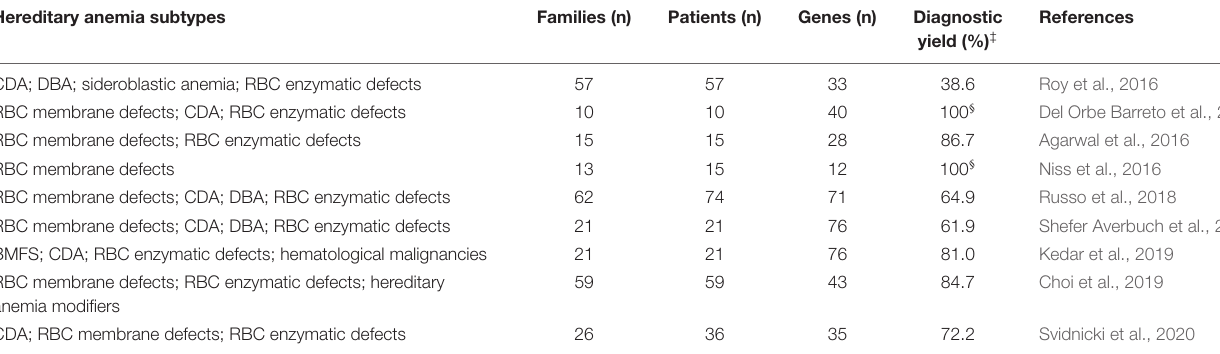
TABLE 1 | Case series of hereditary anemias diagnosed by targeted next-generation